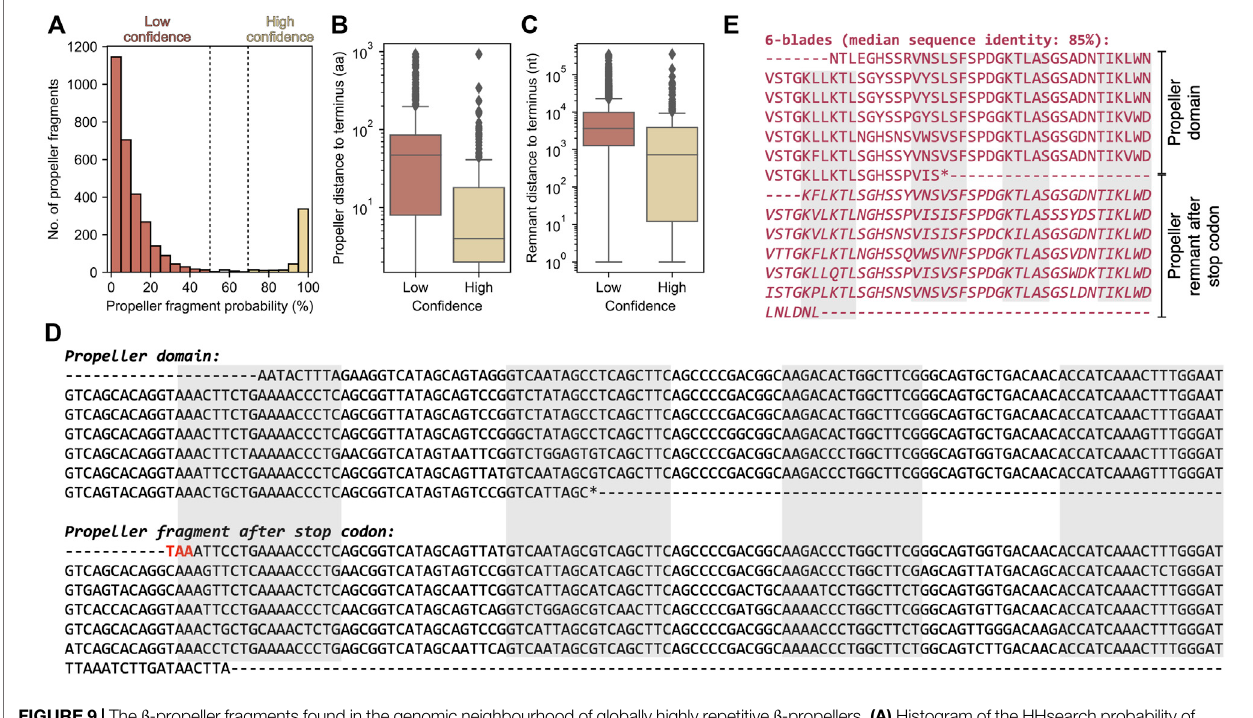
Frontiers in Molecular Biosciences |